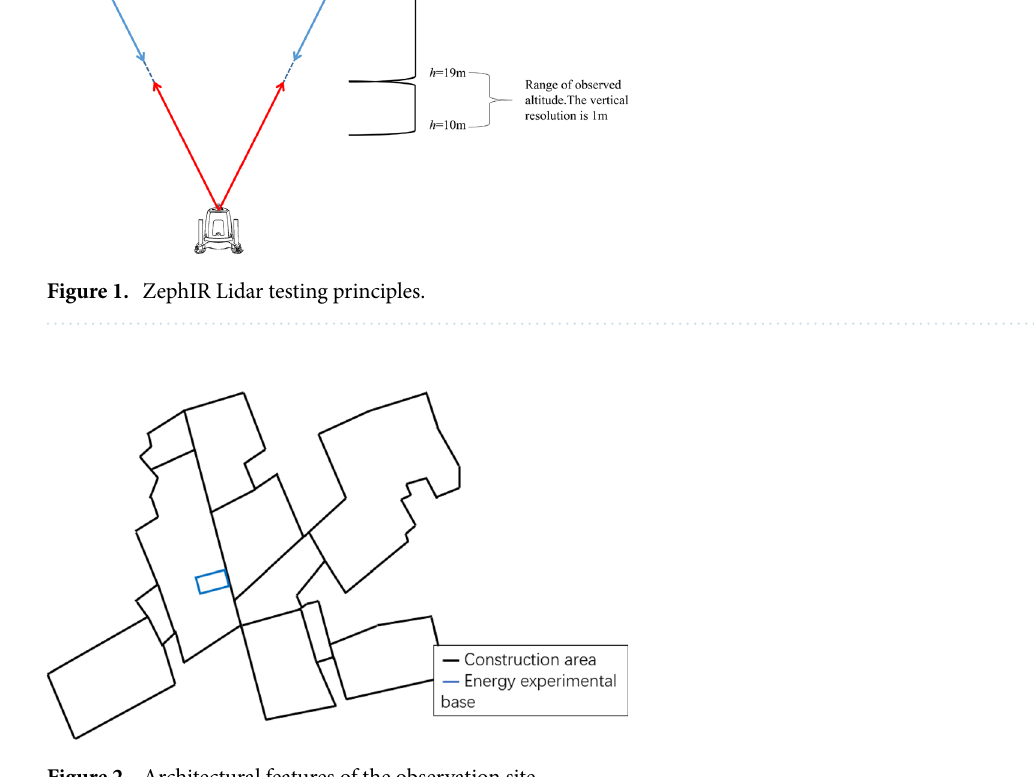
Figure 2. Architectural features of the observation